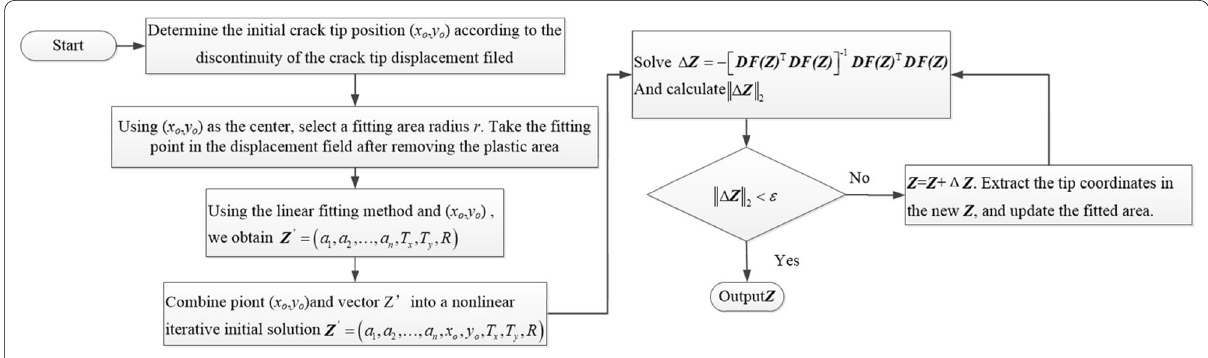
Figure 1 Crack tip location optimisation algorithm